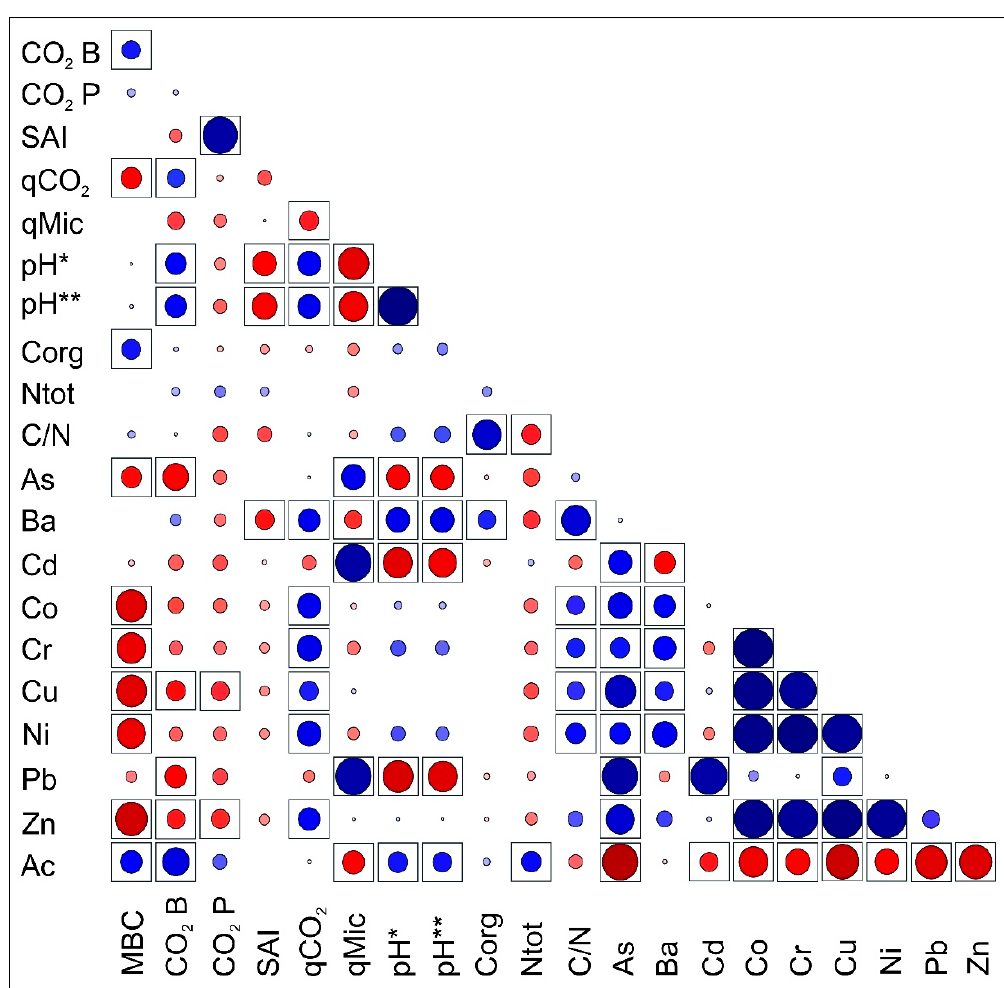
Figure 3. Correlation matrix describing the relations between microbial and chemical parameters of analyzed samples (blue dots represent positive correlation, and red ones represent negative; the bigger and darker is a dot, the strongest relationship between parameters was observed, dots in the box are indicating the significance at p < 0.05 level (pH * = pH(H ₂ O), pH ** = pH (KCl)).